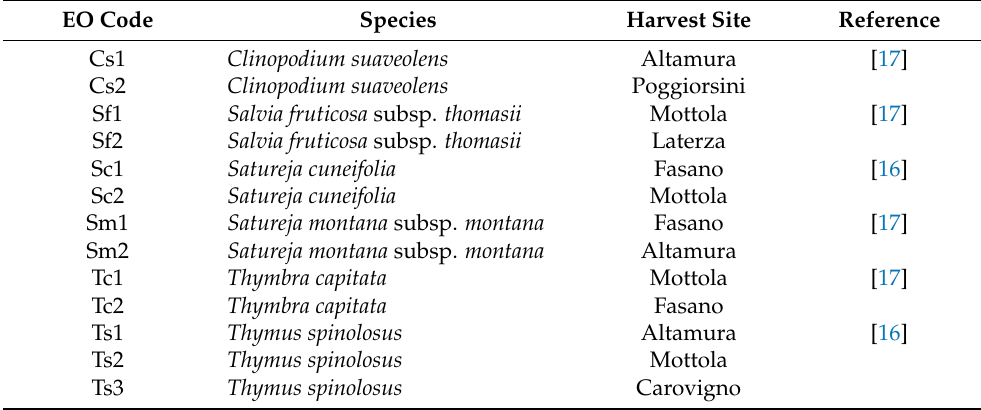
Table 1. Aromatic plant species, harvest location, and extracted oil